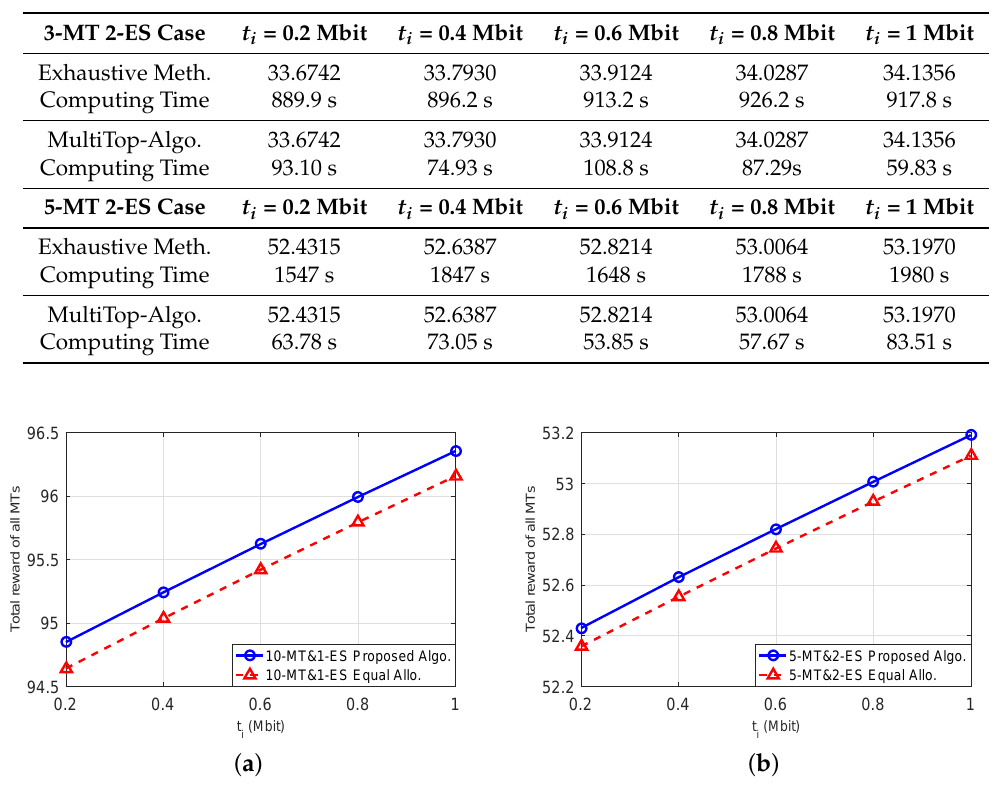
Figure 6. Advantage of our proposed algorithms in comparison with an Equal-Allocation scheme.